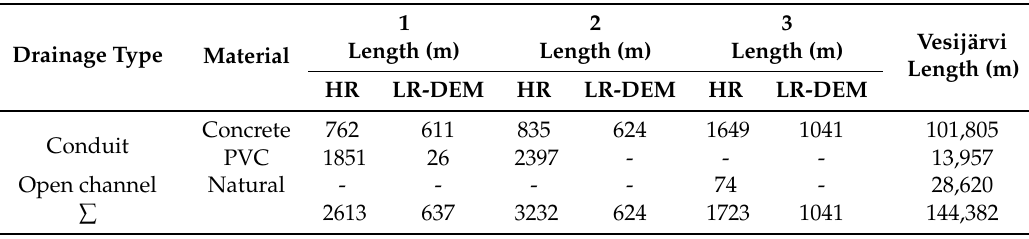
Table 2. Drainage network subdivision for the HR and LR-DEM models of the study catchments and the Vesijärvi